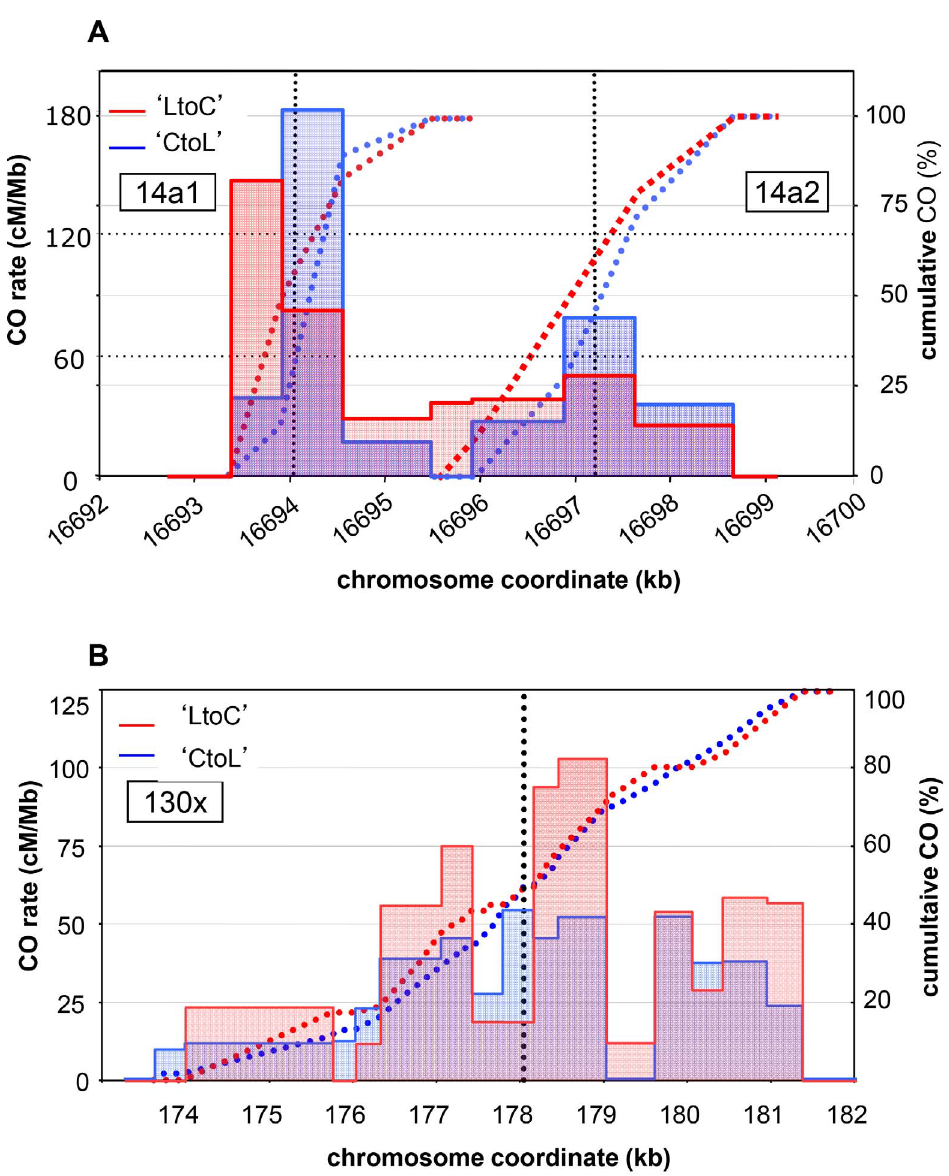
Figure 4. CO distribution and cumulative CO rates for reciprocal orientations at 14a (A) and 130 6 (B). Twenty nine ‘CtoL’ and 33 ‘LtoC’ COs were analyzed at 14a1, 23 and 19 at 14a2, and 75 and 92 at 130 6 . The ‘LtoC’ distribution is presented in red and the ‘CtoL’ in blue. For all three hotspots and both reciprocal orientations, cumulated (from left to right) relative CO rates were scored at successive polymorphic sites along the region. Blue curves: cumulated relative ‘CtoL’ CO rates. Red curves: cumulated relative ‘LtoC’ CO rates. Blue histogram: distribution of ‘CtoL’ CO rates. Red histogram: distribution of ‘LtoC’ CO rates. Grey dotted vertical lines: median positions of the hotspots.